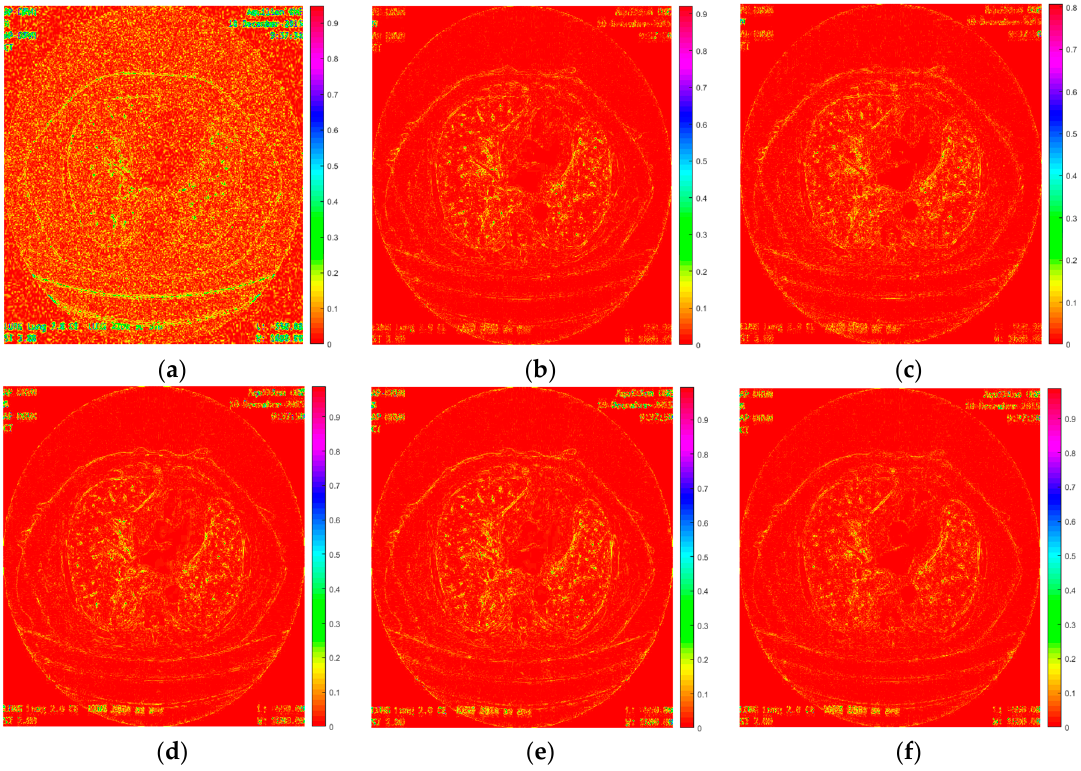
Figure 15. Absolute differences between the images (noise level = 20) restored by different methods and the ground truth image. ( a ) is the bicubic interpolation, ( b ) is the SRMD, ( c ) is the SRCGAN, ( d ) is the RED-CNN, ( e ) is the RDN, and ( f ) is the proposed method.